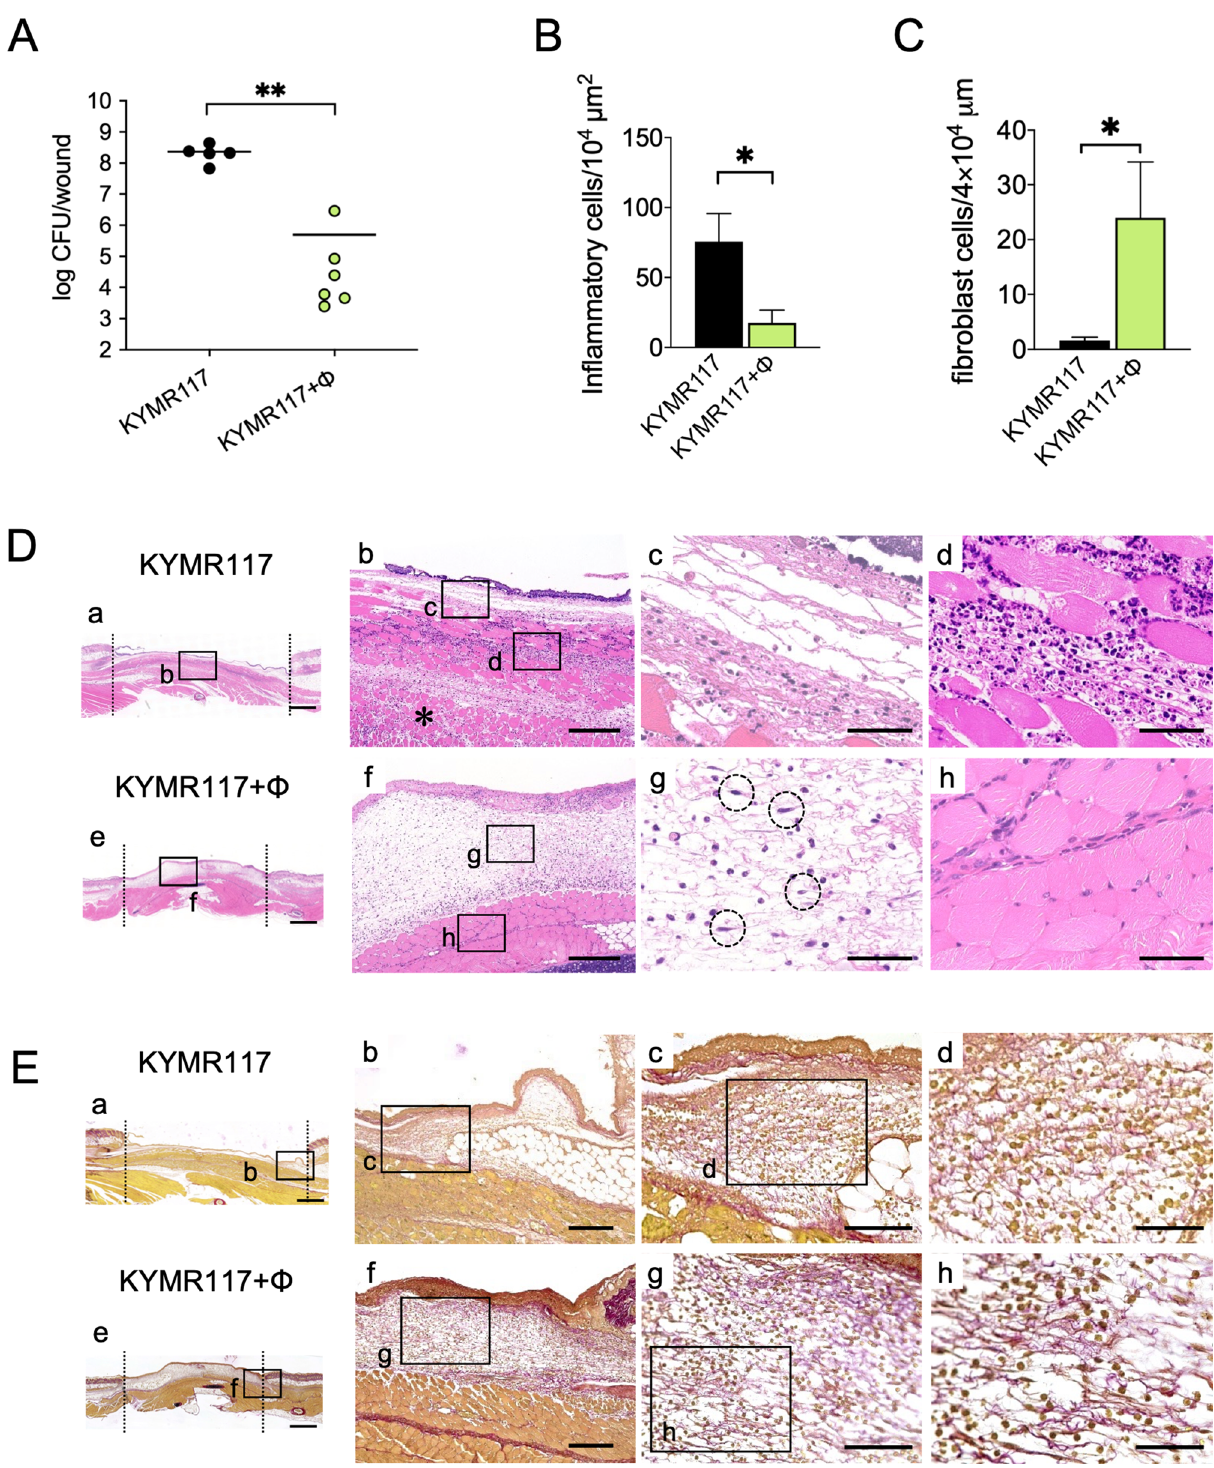
Figure 3. Effects of phiMR003 on the bacterial loads and histopathological analyses in KYMR117 infection. ‘KYMR117 + ϕ in the graphs indicates the samples prepared from mice coinoculated with KYMR117 and phiMR003. ( A ) The number of bacteria in the tissue was counted 48 h after infection. The results represent the mean CFU/wound (n = 5). ( B ) The density of the infiltrated inflammatory cells was quantified using three areas randomly chosen in the abscesses. The data indicate the mean number of cells per 10 4 µm 2 (n = 3). ( C ) Emerged fibroblasts were quantified using three areas randomly chosen in the abscesses. The data indicate the means of the number of cells per 4 × 10 4 µm 2 (n = 3). ( D ) Mouse skin tissues observed by haematoxylin and eosin (H&E) staining at 48 h after infection. Data are representative of three mice in each group. Scale bars, 1 mm in a and e, 200 µm in b and f, and 50 µm in c, d, g and h. ( E ) Collagen and elastin fibres in the mouse skin were detected by Elastica van Gieson staining. Scale bars, 1 mm in a and e, 200 µm in b and f, 100 µm in c and g, and 50 µm in d and h. The micrographs of a-h in ( D ) and ( E ) are the areas indicated with squares a-h, respectively. The asterisk in ( D )-b indicates the lesion of infection in the deep tissue. Error bars indicate the standard errors of the means (SEMs). *, P < 0.05; **, P <